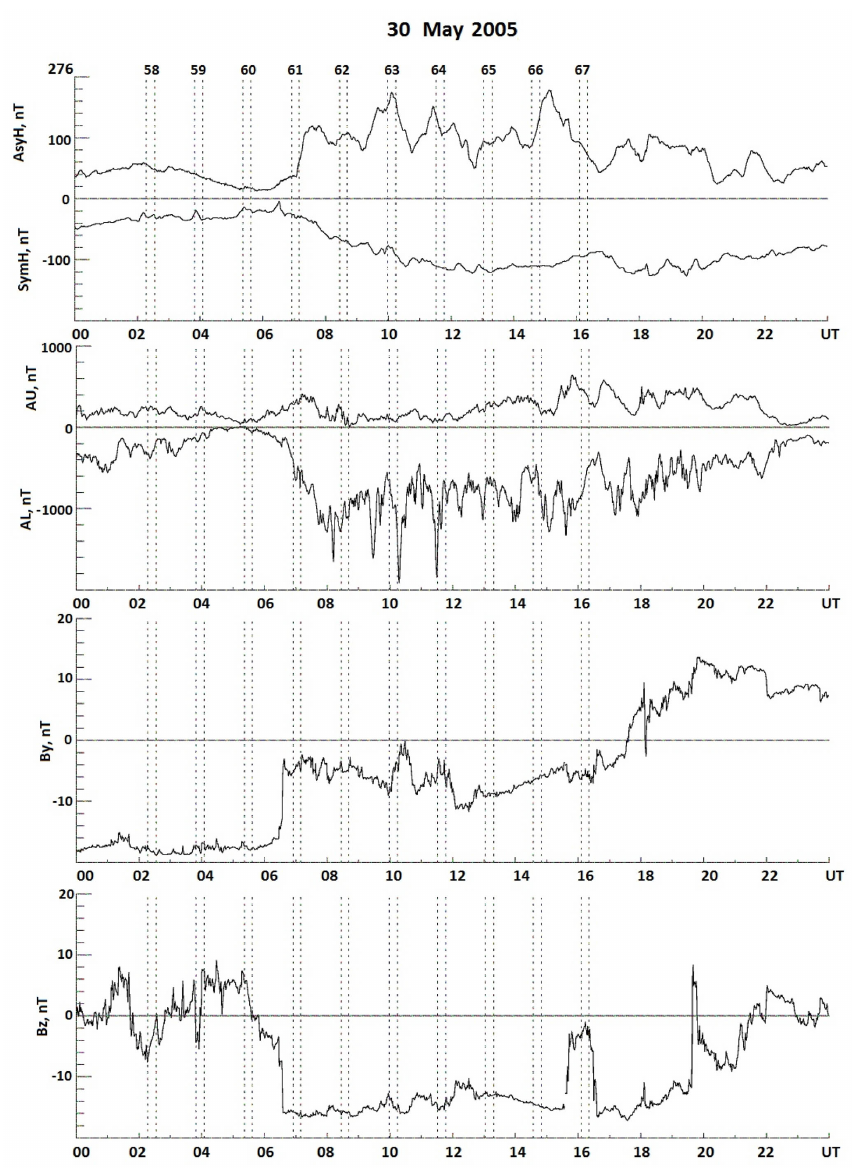
Figure A5. One-minute values of the AsyH, SymH, AU, and AL indices and of the B y and B z components of the IMF for the storm on 30 May 2005 (analysis interval 02:00–17:00UT, orbits 27658–27667). The time of each orbit and its orbit number are indicated as in Fig. 1 of the